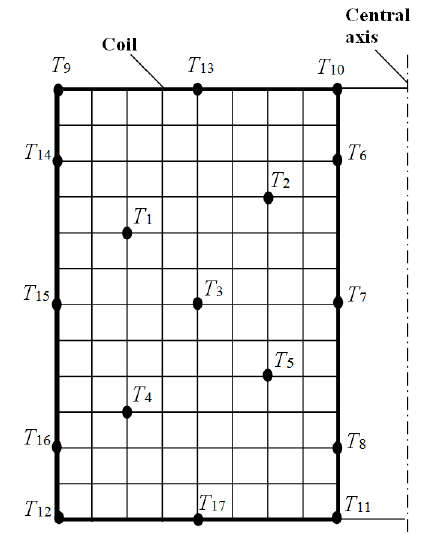
Figure 2. Measuring points of the coil in laboratory measurements.